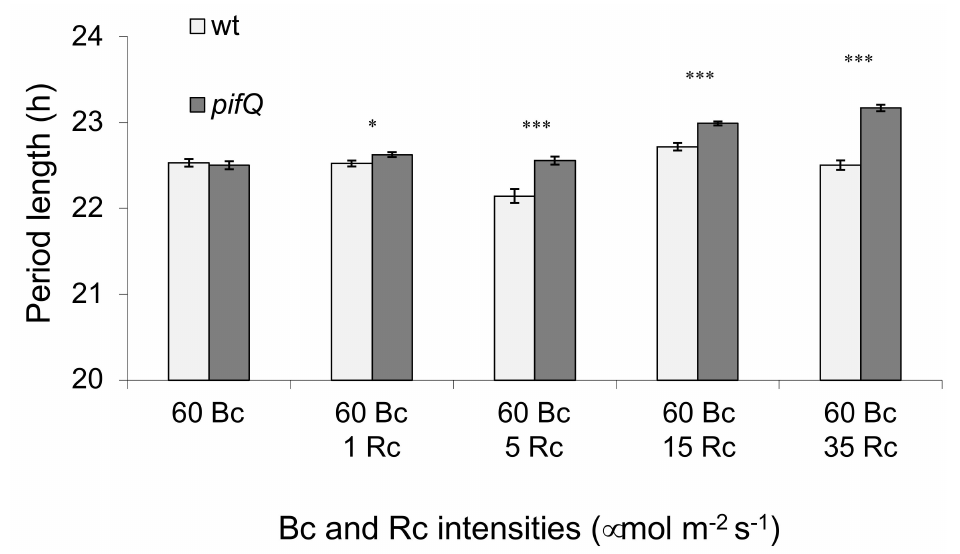
Figure 2. Low levels of red light are sufficient to restore the long period pifQ phenotype. pifQ CCA1:LUC and wt CCA1:LUC lines were entrained for 8 days in 14 h: 10 h, light: dark (white light, 100 µ mol m − 2 s − 1 ) on medium, supplemented with 3% sucrose before being transferred to different constant light conditions (60 µ mol m − 2 s − 1 Bc, 60 µ mol m − 2 s − 1 Bc + 1 µ mol m − 2 s − 1 Rc, 60 µ mol m − 2 s − 1 Bc + 5 µ mol m − 2 s − 1 Rc, 60 µ mol m − 2 s − 1 Bc + 15 µ mol m − 2 s − 1 Rc, 60 µ mol m − 2 s − 1 Bc + 35 µ mol m − 2 s − 1 Rc), and luciferase activity measured. Average of 2–4 biological repeats. n ≥ 103. * p < 0.05, *** p < 0.001 (Student two-tailed t